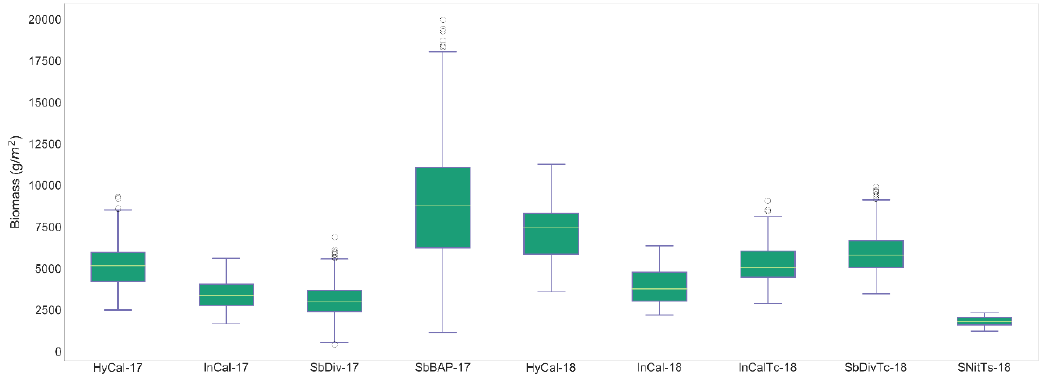
Figure 19. The box plot for the fresh biomass data for all the experiments conducted in the 2017 and 2018 growing seasons.